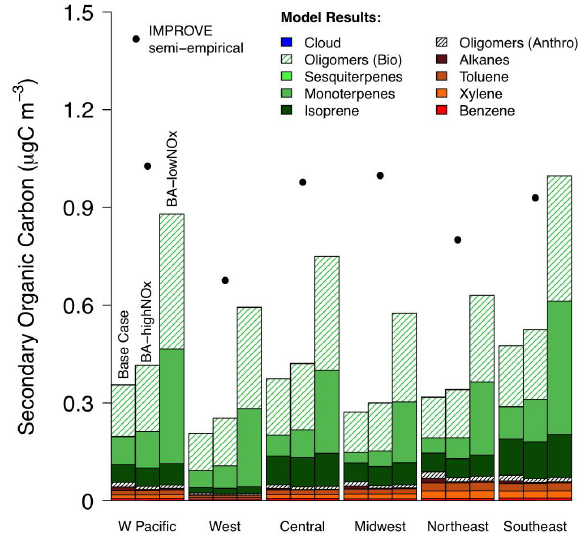
Fig. 10. Regional comparison of model-based (base case and best available high- and low-NO x cases) and observationally- based secondary organic carbon (SOC) mass concentrations. Observationally-based SOC concentrations were calculated from data averaged over the simulation period from 155 IMPROVE